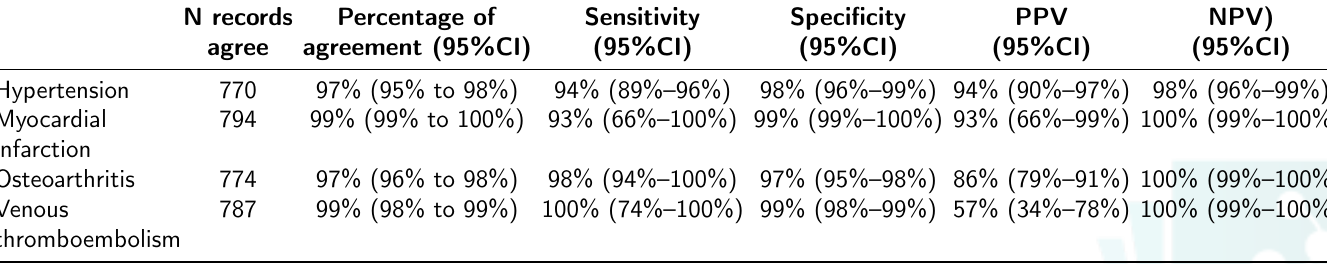
Table 2: Agreement and accuracy of ‘medical history’ data field in